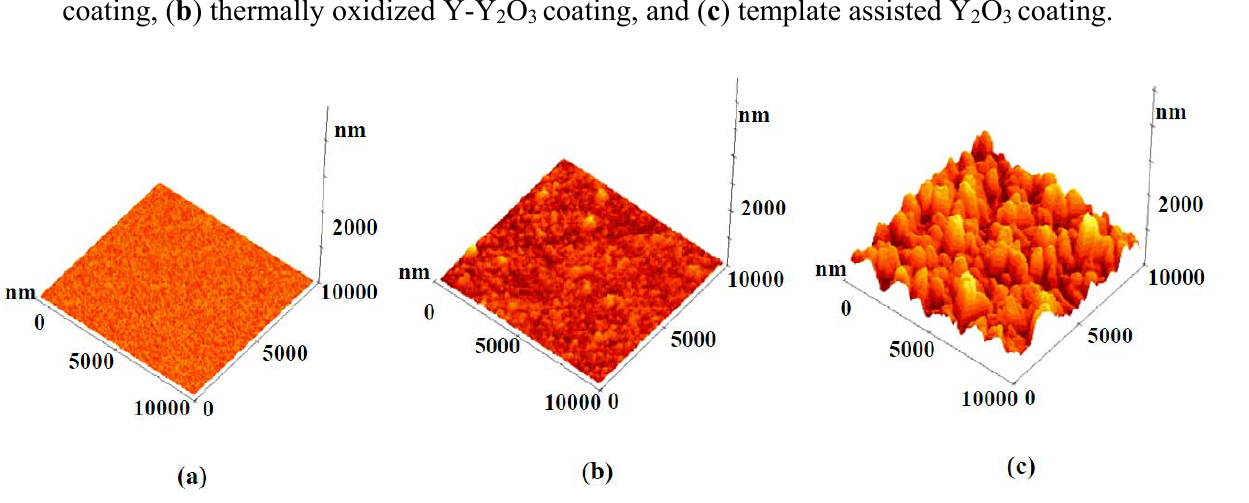
Figure 4. 3D atomic force microscopy (AFM) images of: ( a ) sputter deposited Y coating, ( b ) thermally oxidized Y-Y